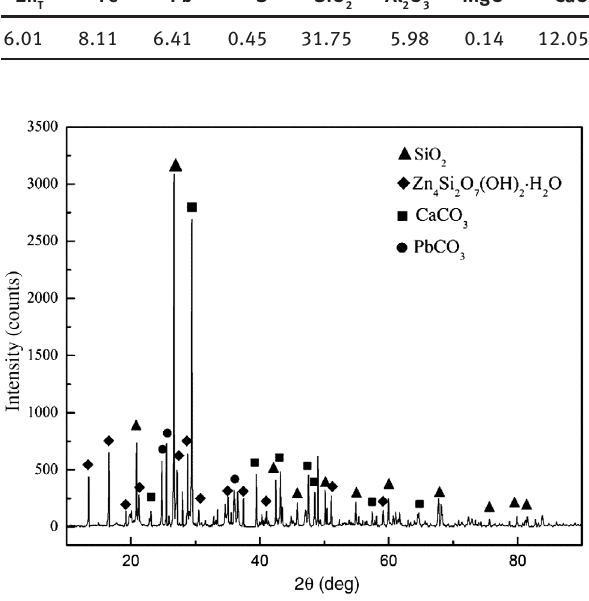
Figure 1: X-ray diffraction (XRD) pattern of low-grade oxide zinc ore.